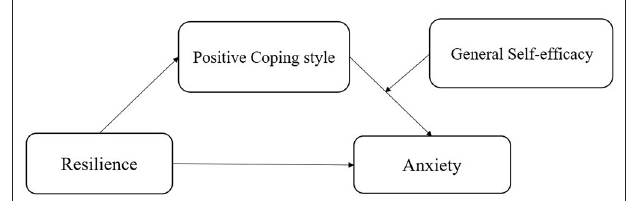
FIGURE 1 | The schematic model of proposed moderated mediation